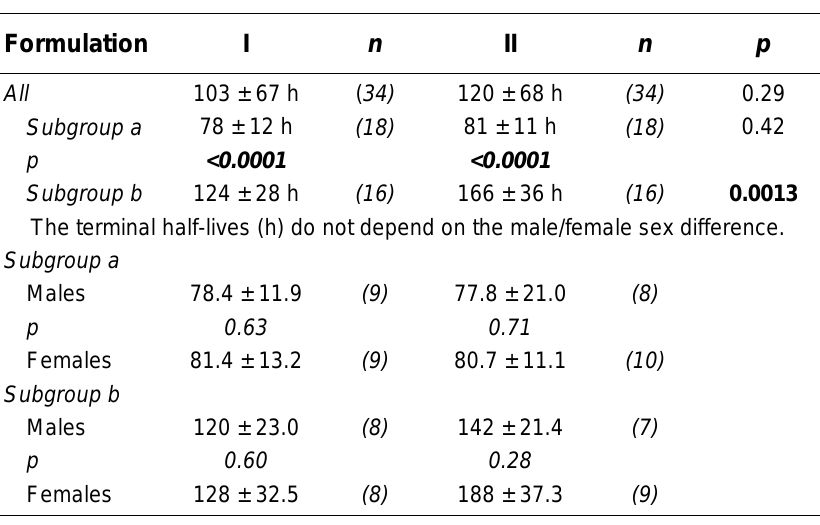
Variation in the Terminal Elimination Half-Life (h) of Ramiprilat in Apparent Groups of Subjects (34